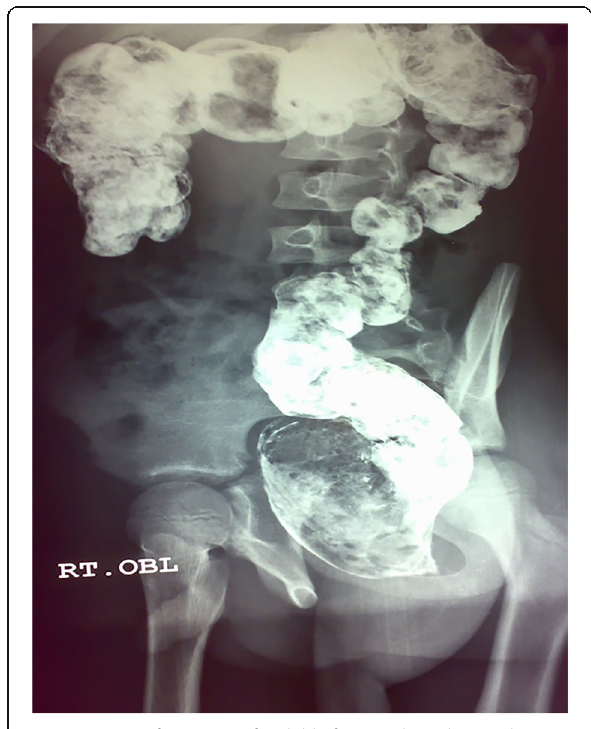
Fig. 2 Gastrografin enema of a child after a Duhamel procedure showing a long